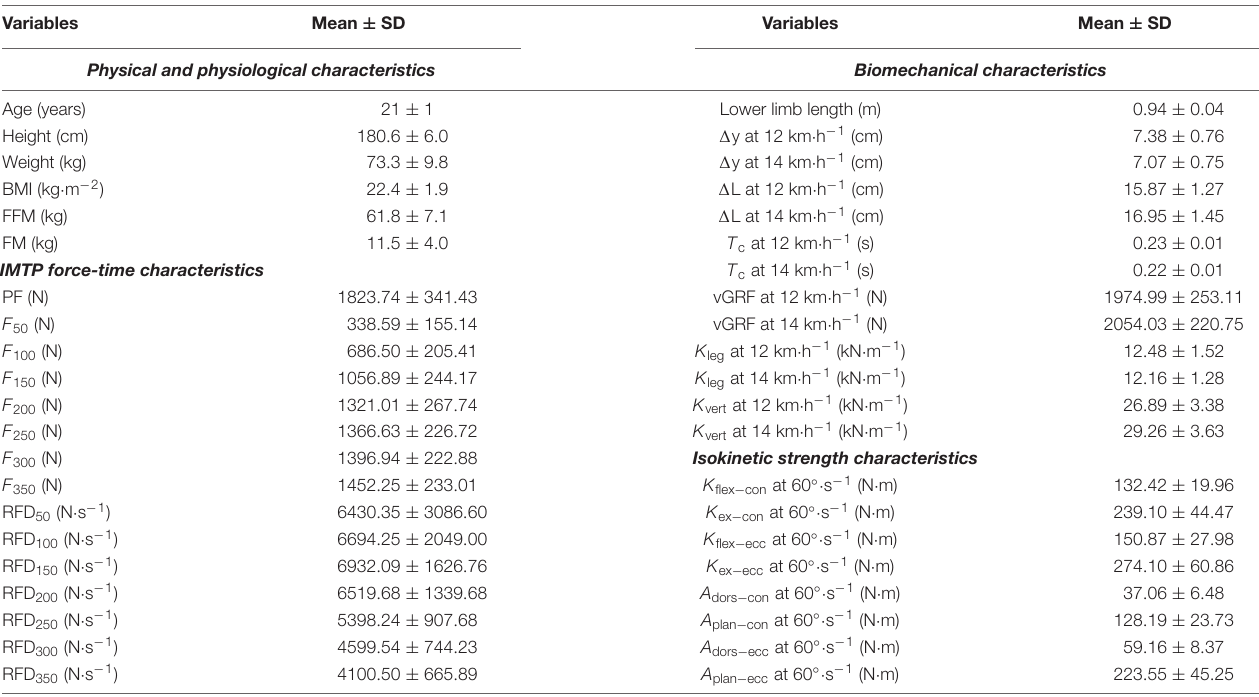
TABLE 1 | Physiological, biomechanical, and neuromuscular strength characteristics of the participants ( n = 31). Variables Mean ± SD Variables Mean ±